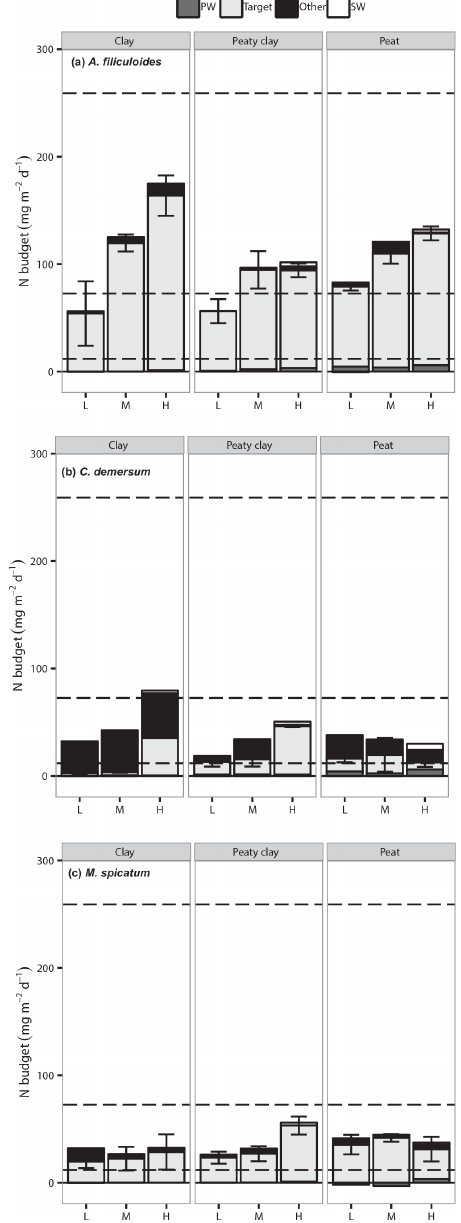
Figure 5. N distribution in surface water, pore water, tar- get species and other plants subjected to different nutrient loadings (L: 0.43mgPm − 2 d − 1 ; M: 21.4mgPm − 2 d − 1 ; H: 85.7mgPm − 2 d − 1 ) from (a) A. filiculoides , (b) C. demersum and (c) M. spicatum macrophyte systems. Standard errors are given only for target plants. PW: pore water; SW: surface water. Positive values represent N accumulation in relative parts; negative values repre- sent N release from respective compartments. The lowest, medium and highest dashed lines represent external N input at low, medium and high N loadings (including actual atmospheric N deposition),